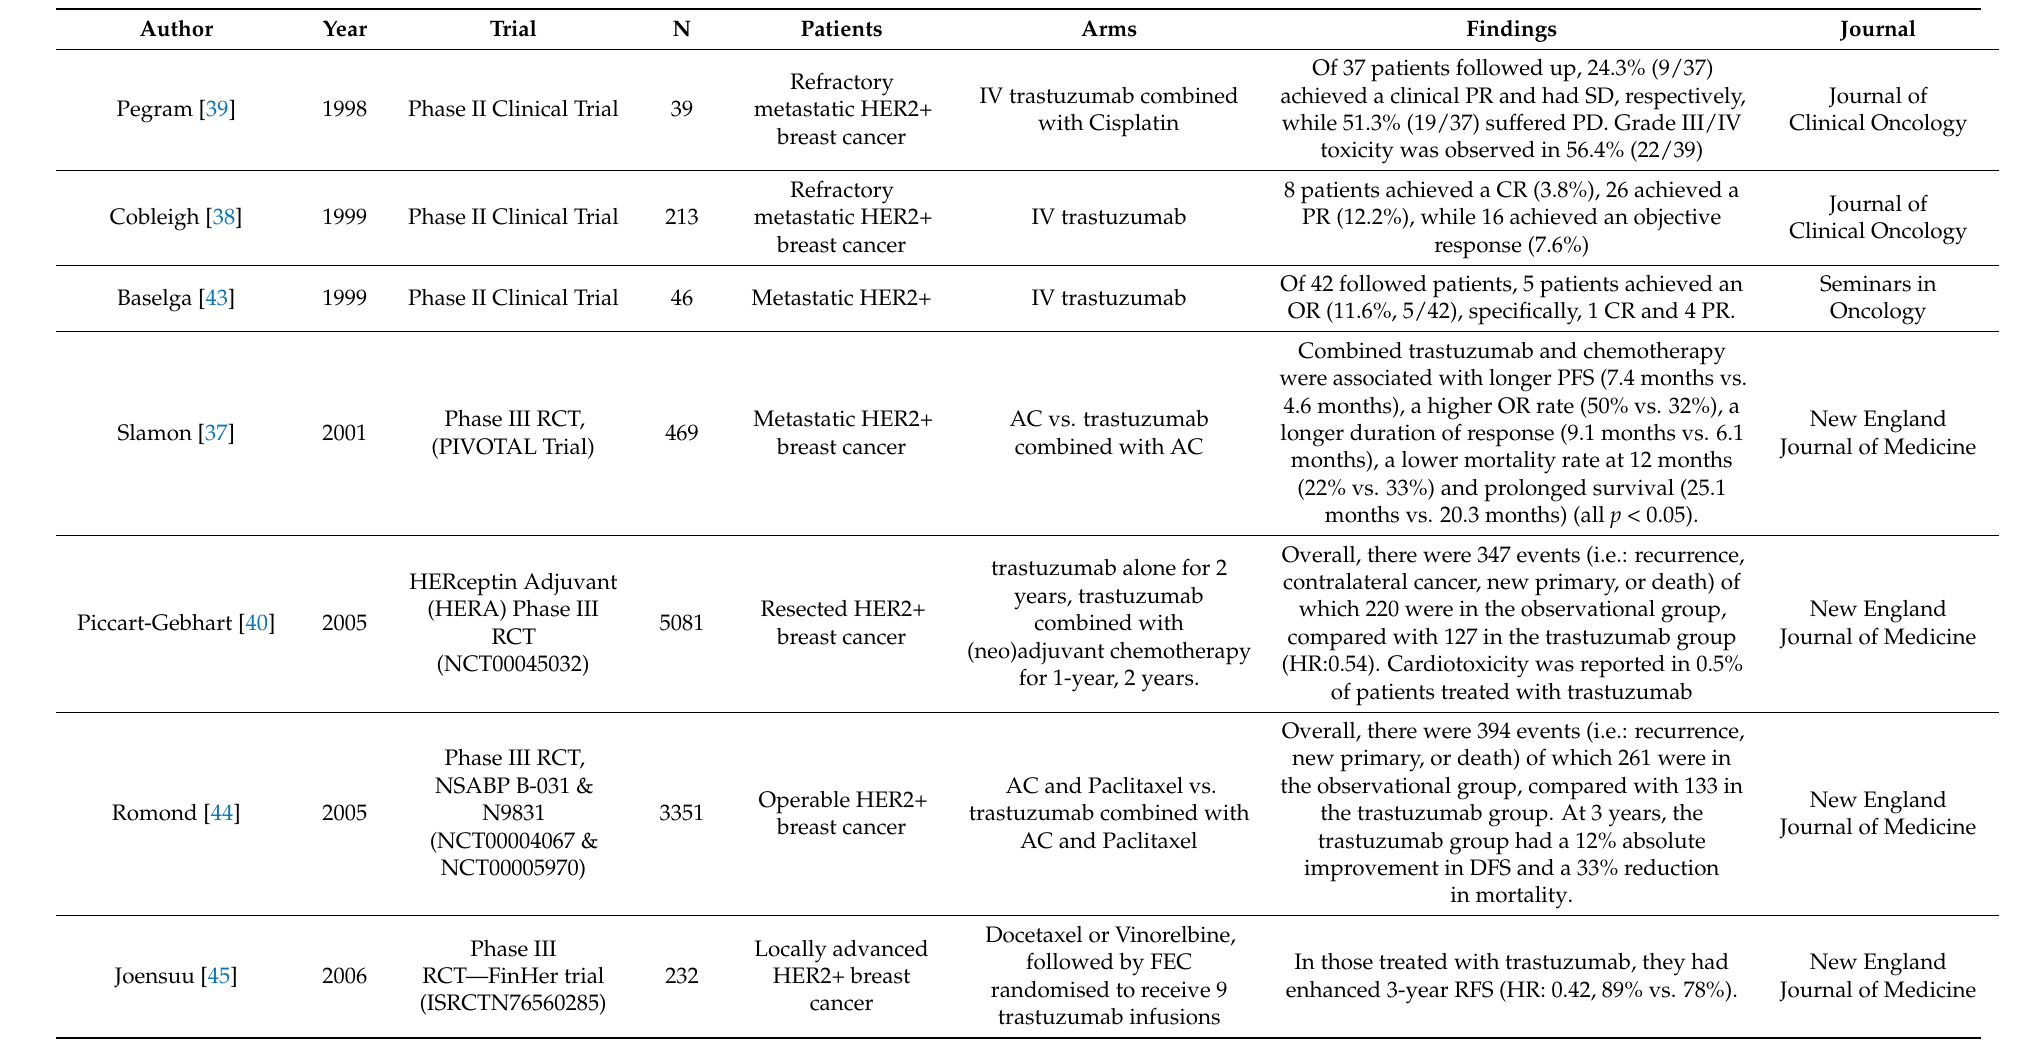
Table 1. Table outlining the landmark randomised clinical trials outlining the role of trastuzumab in human epidermal growth factor receptor-2 positive breast